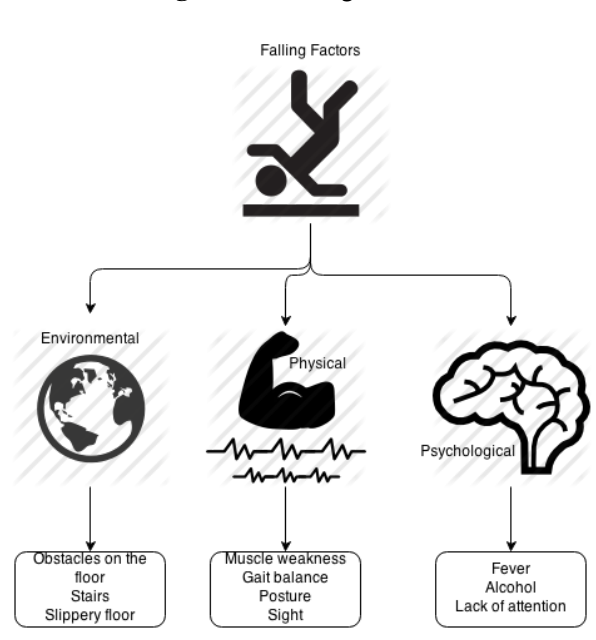
Figure 8. Falling